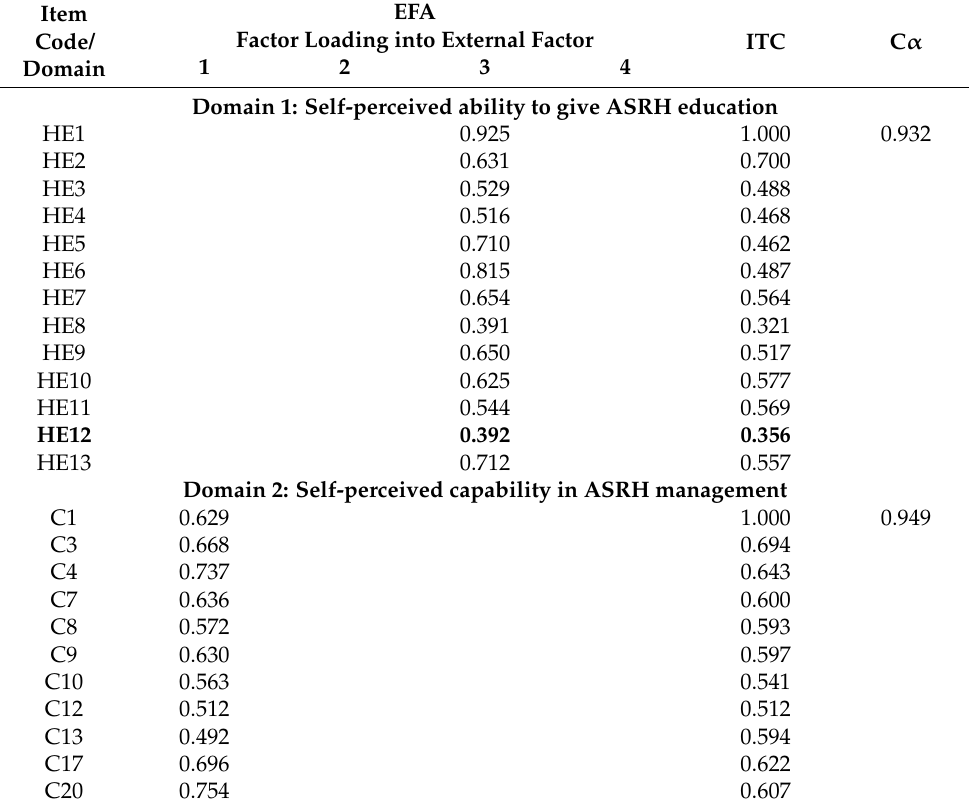
Table 3. EFA and reliability analysis, ITC, and domain-specific Cronbach’s α